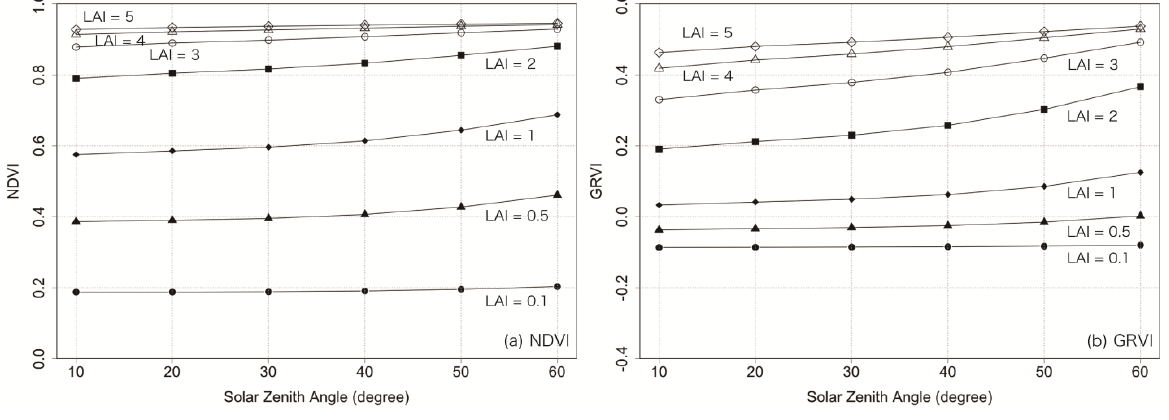
Figure 5. Relation between vegetation indices (( a ) NDVI and ( b ) GRVI) and solar zenith angles simulated by the PROSAIL model for a range of LAI values (0.1, 0.5, 1, 2, 3, 4, 5).